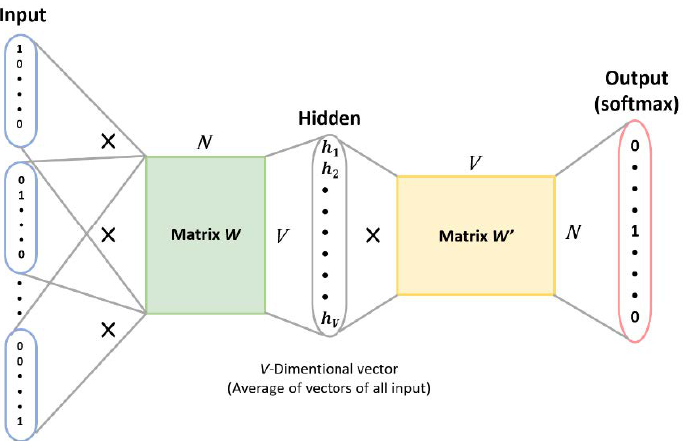
Figure 16. CBOW architecture used in Chinese speech recognition